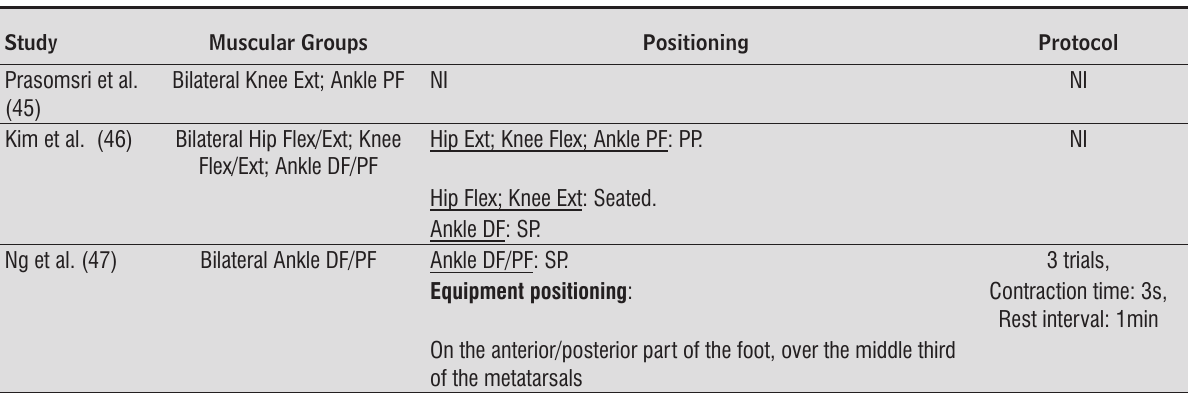
Table 2 - Data extraction of the 30 studies, which assessed the strength of the lower limb muscles with portable dynamometry in subjects with stroke and provided information regarding the positioning or the data col- lection